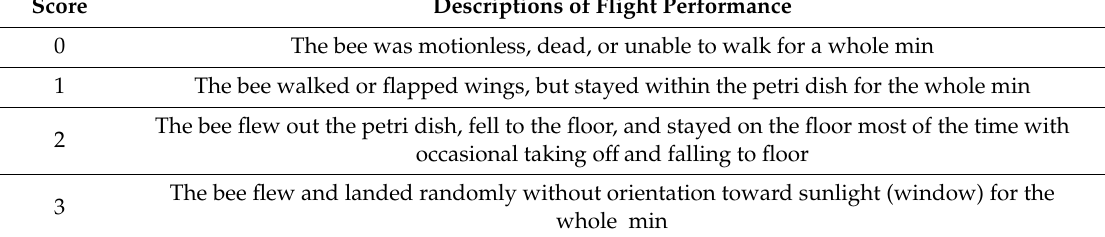
Table 2. Standards for scoring honey bee orientation and flight performance after chemical treatment. Score Descriptions of Flight